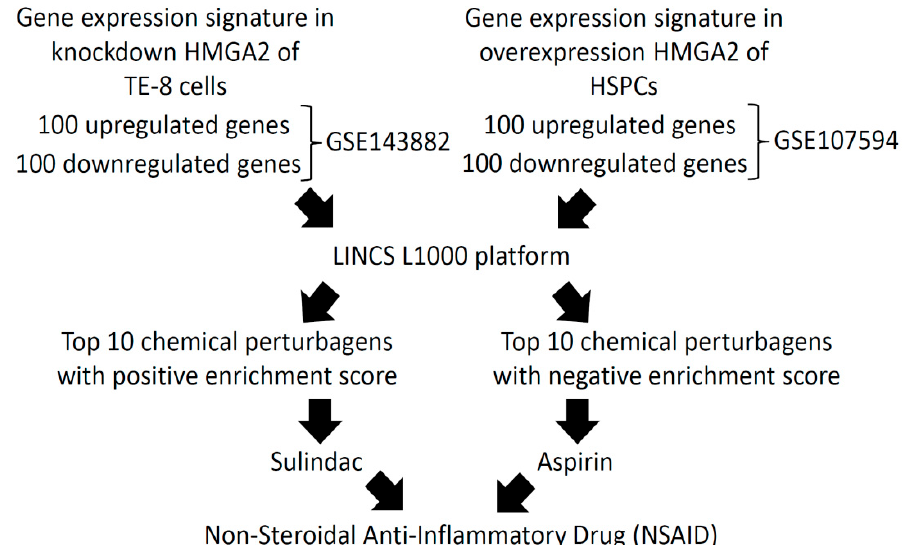
Figure 1. Diagram of new human high-mobility group A2 (HMGA2) inhibitor identification. Two Gene Expression Omnibus (GEO) databases (i.e., GSE143882 and GSE107594) were selected from the National Center for Biotechnology Information (NCBI). The top 100 up- and downregulated genes were analyzed from the two GEO databases and further queried using the Library of Integrated Network-based Cellular Signatures (LINCS) L1000 platform to predict new inhibitors of HMGA2. TE-8, esophageal cancer cells; HSPCs, hematopoietic stem and progenitor cells.